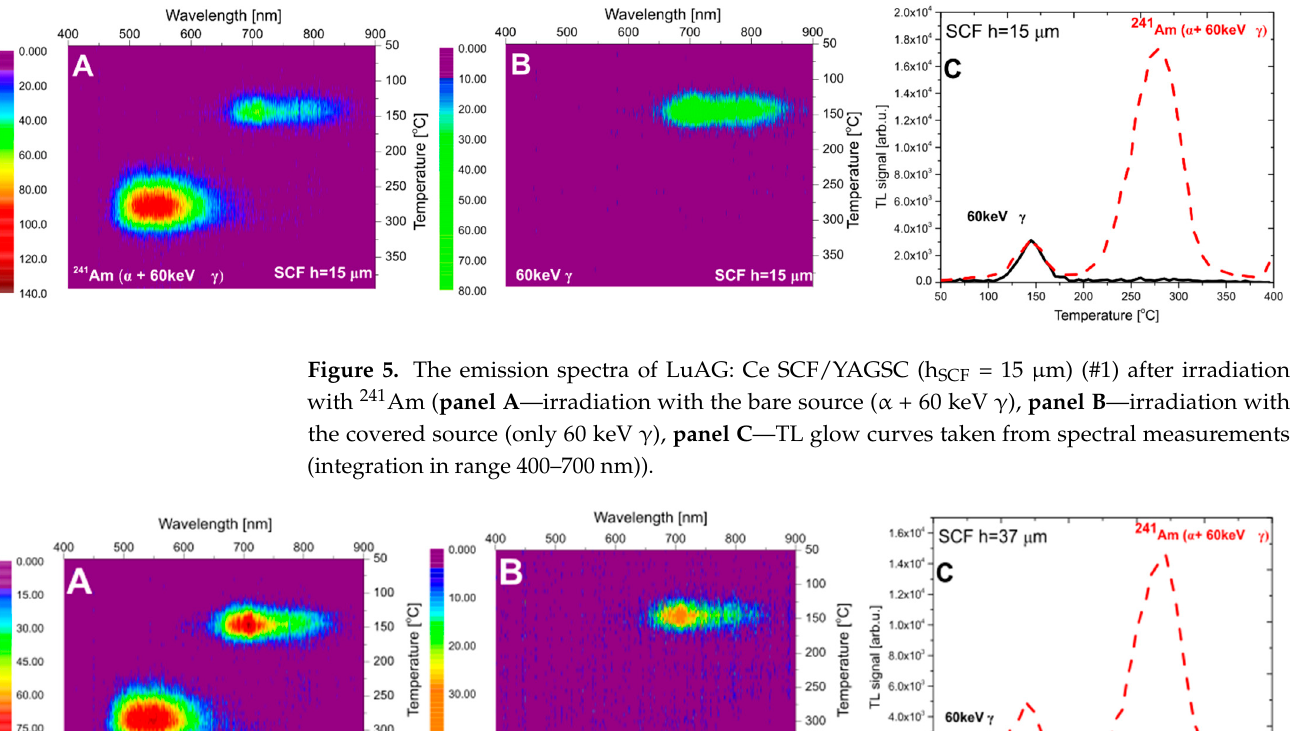
Figure 4. TL glow curves of the YAG substrate after irradiation with 90 Sr/ 90 Y measured with the Ocean Optics QE Pro 00689 spectrometer ( panel A ) and with the TL reader utilizing a CCD camera ( panel B ).